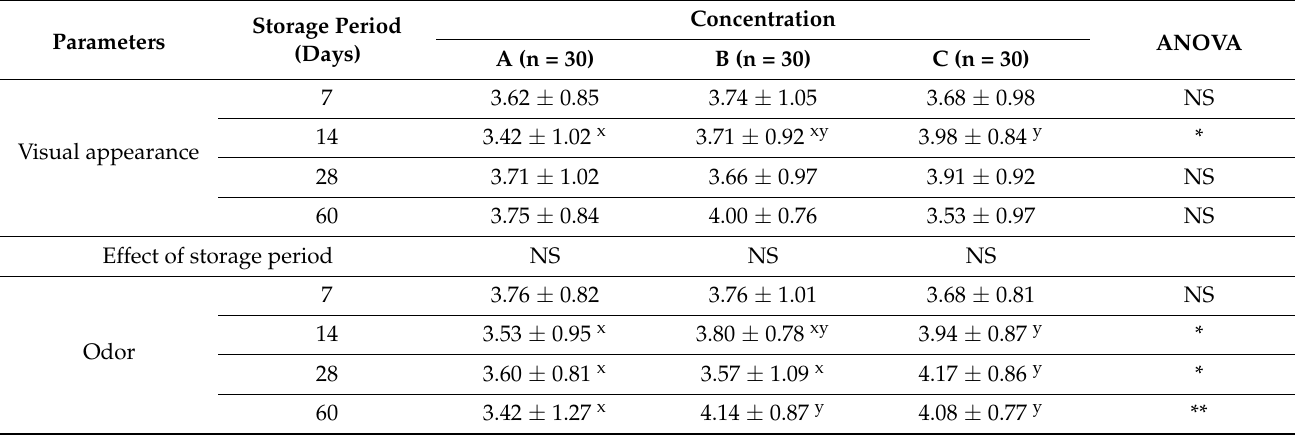
Table 2. Effect of different added concentrations of saffron on sensory characteristics (visual appearance, odor, and flavor; means ± s.e.) of sachets of ham slices.